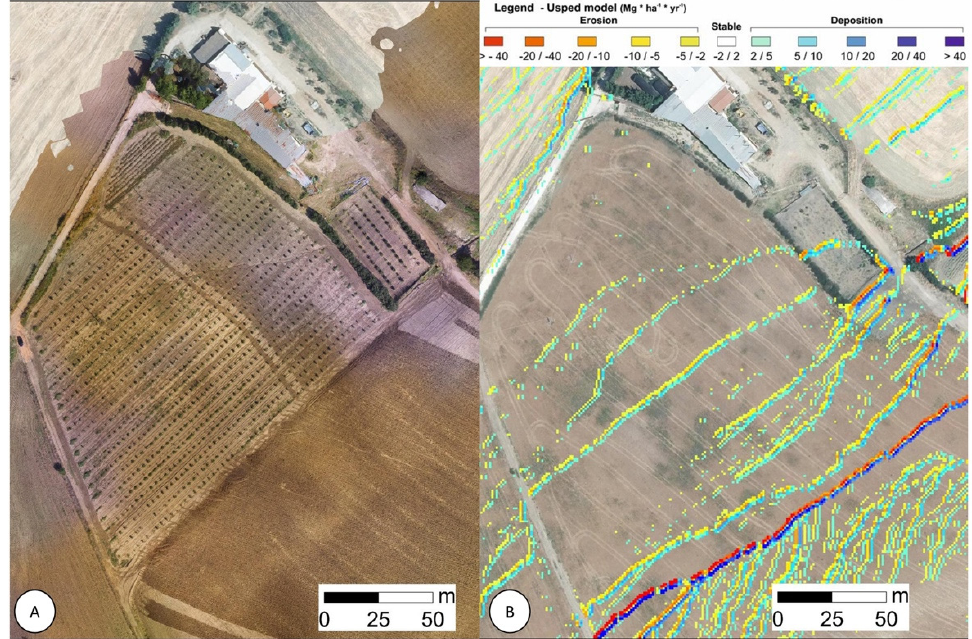
Figure 8. Details of the cultivated hazelnut area, ( A ) orthophoto derived from UAV data; ( B ) erosion map by USPED model.